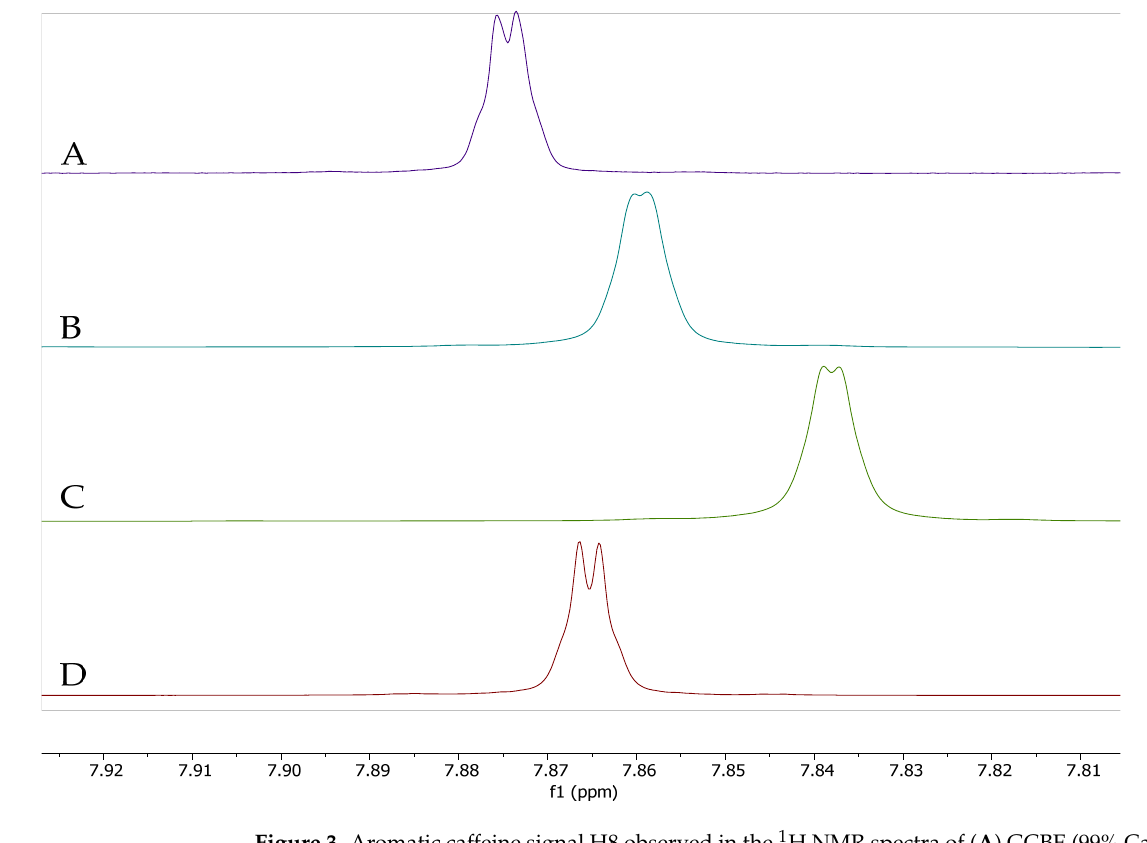
Figure 3. Aromatic caffeine signal H8 observed in the 1 H NMR spectra of ( A ) GCBE (99% Caffeine) in phosphate buffered D 2 O pD 7.1 compared to ( B ) CEWCCE, ( C ) Mixtures of synthetic caffeine (Sigma, St Lois, MO, USA) and coffee cherry chlorogenic acids extracts containing 40% chlorogenic acids (obtained from VDF-FutureCeuticals), and ( D ) Mixture of synthetic caffeine and chlorogenic acids commercially available from Sigma. Table 1. Chemical shift data of 1 H NMR spectra of caffeine, CEWCCE, and mixtures of caffeine and chlorogenic acids in phosphate-buffered D 2